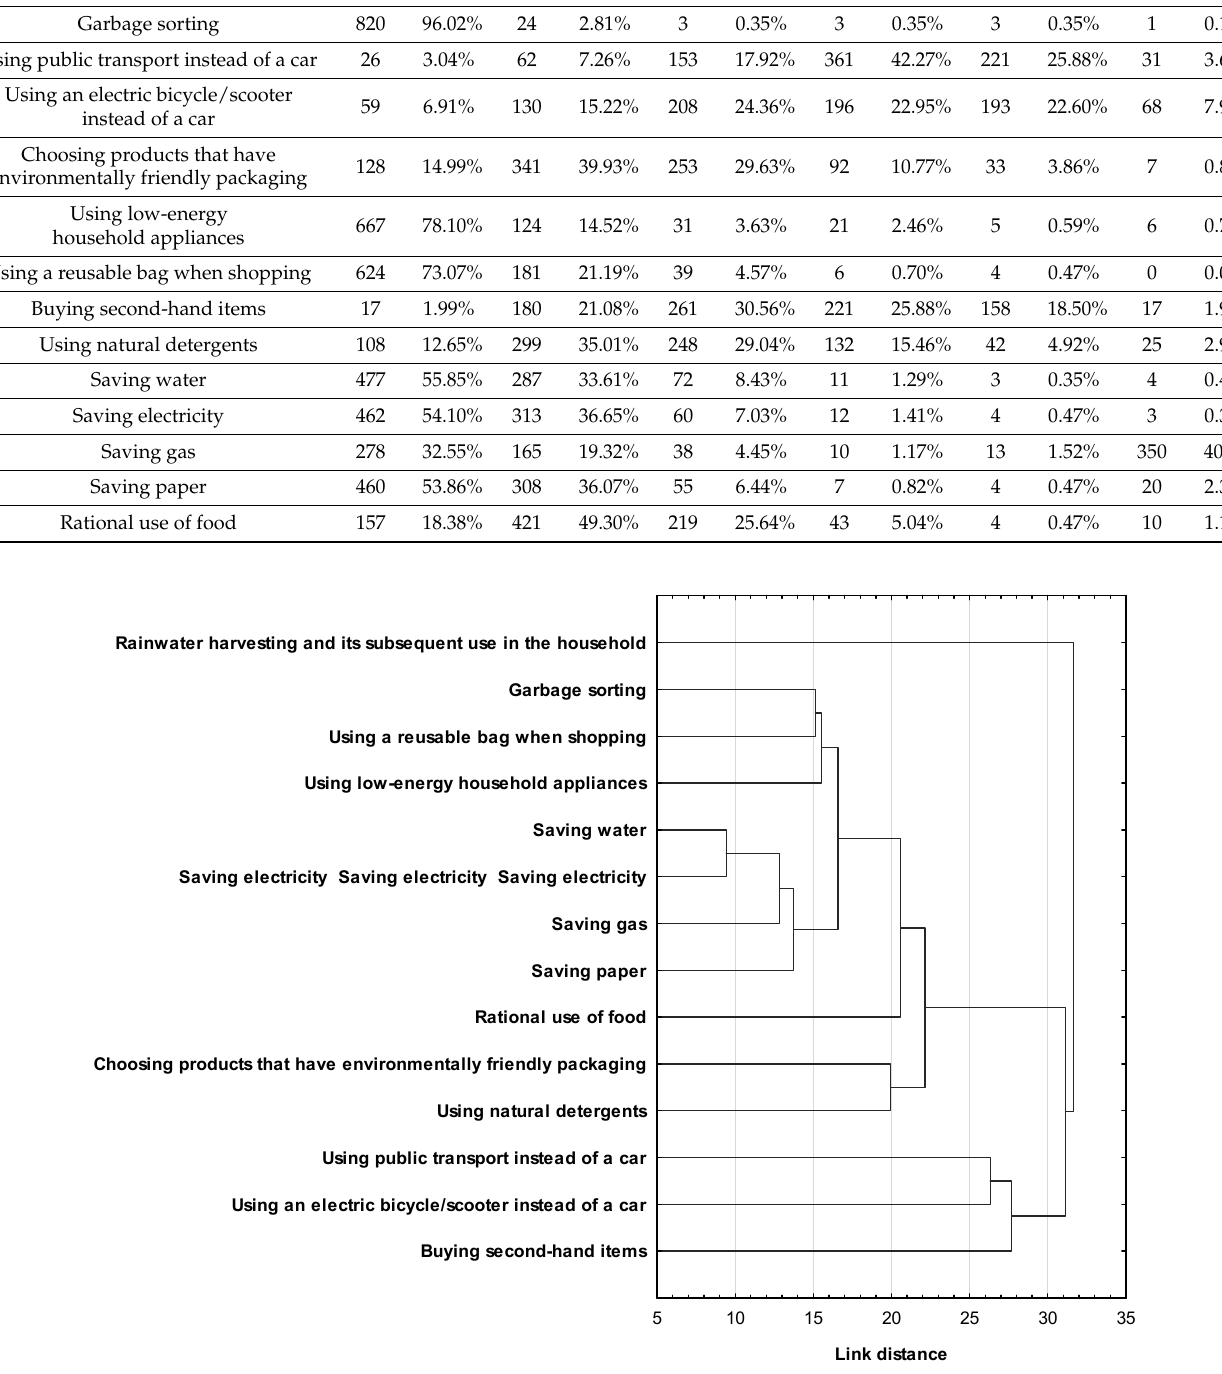
Figure 1. Dendrogram obtained for individual pro ‐ ecological behaviors in terms of the frequency of their adoption by respondents (results of cluster analysis using agglomeration).